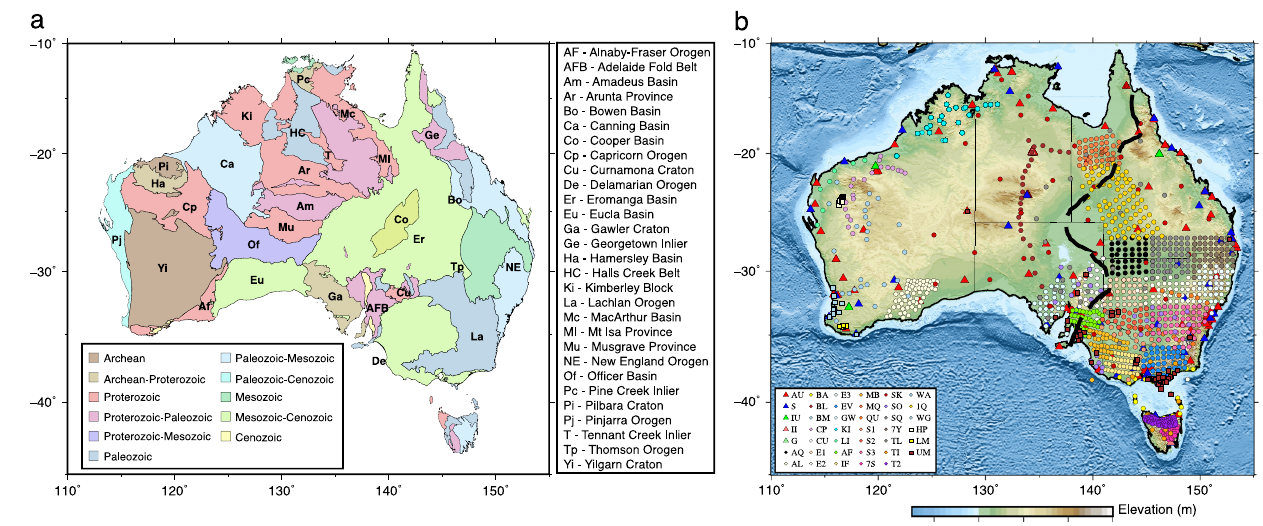
Fig. 1 | Tectonic subdivision and station distribution of the Australian con- tinent. a Major geological domains. The domain boundariesand the outline of the Cooper basin are from ref. 47 . b Distribution of seismic stations used in this study,